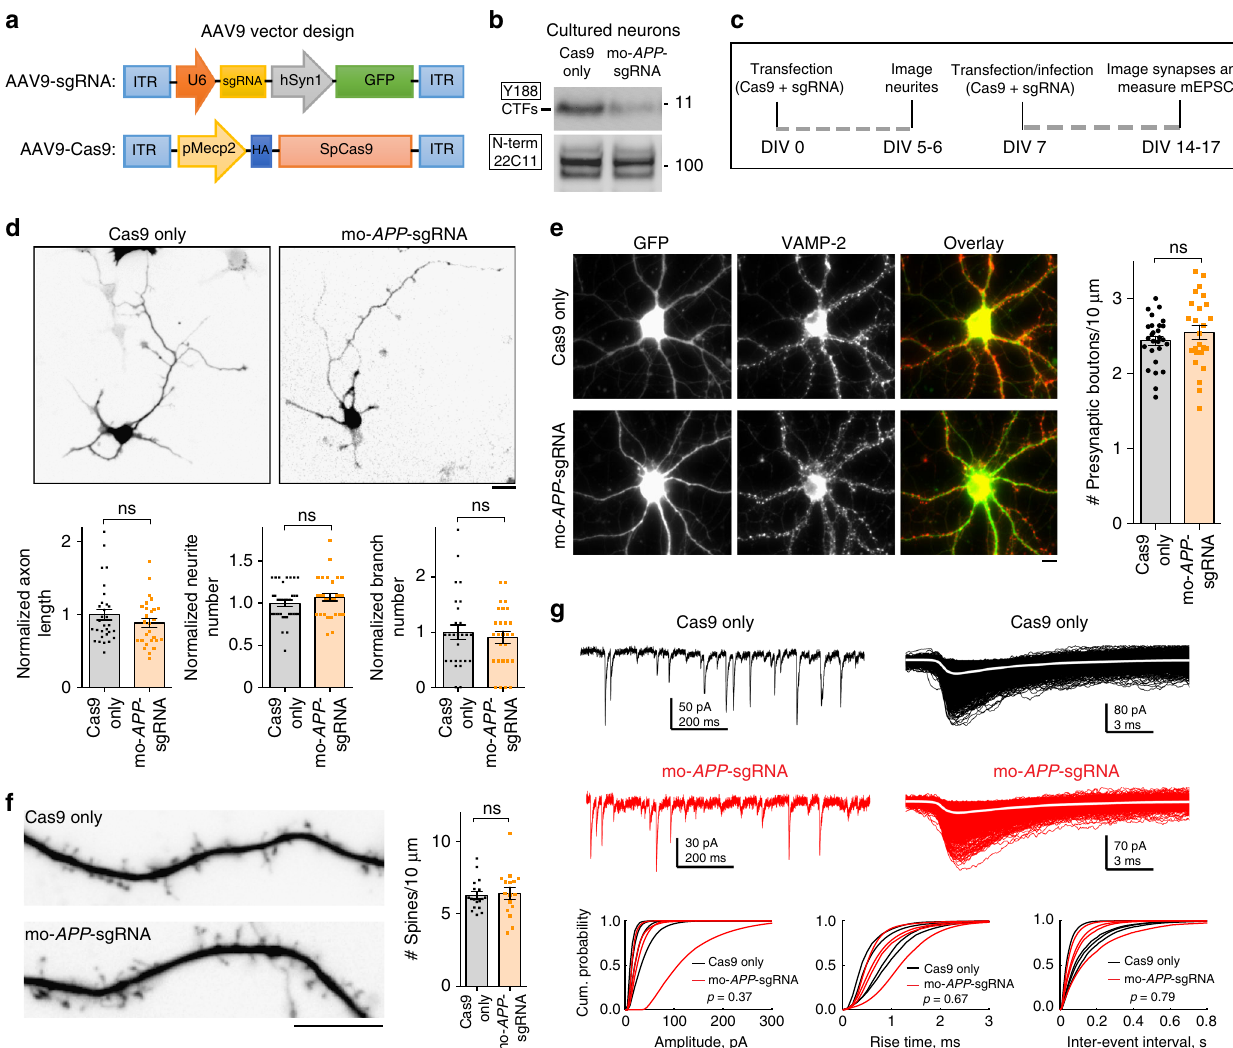
Fig. 3 Effect of APP C-terminus editing on neuronal physiology. a AAV9-sgRNA and AAV9-Cas9 expression vectors. Note that the sgRNA vector co- expresses GFP and the Cas9 is tagged to HA, for identi fi cation of transduced neurons. b Cultured hippocampal neurons were transduced with AAV9s carrying mo- APP -sgRNA/Cas9 (or Cas9 only) and immunoblotted with the Y188 and 22C11 antibodies (with GSI). Note attenuation of CTFs by the mo- APP -sgRNA. c Neurons were transfected (at the time of plating) with APP CRISPR. Neuritic/axon outgrowth was analyzed after 5-6 days. Neurons were transfected or infected at DIV7 with APP CRISPR, and synapse structure/function was analyzed after 14 – 17 days. d Top: Representative images of neurons transfected with the mo- APP -sgRNA/Cas9 (or Cas9 only). Bottom: Quanti fi cations of axon length and number of neurites/branches; note that there was no signi fi cant difference (mean ± SEM; axon length: 30 cells for control and 27 cells for mo- APP -sgRNA from two independent experiments, p = 0.2462; neurite number: 35 cells for control and 31 cells for mo- APP -sgRNA from two independent experiments, p = 0.2289; branch number: 27 cells for both conditions from two independent experiments, p = 0.6008 by two-tailed t -test ; ns = non-signi fi cant). Scale bar 20 μ m. e Neurons were infected with mo- APP -sgRNA/Cas9 (or Cas9 only), and fi xed/stained with the presynaptic marker VAMP2. Note that the presynaptic density (VAMP2 puncta) was similar in both groups (mean± SEM of VAMP2 staining along 27 dendrites for control and 25 dendrites for mo- APP -sgRNA from two independent experiments, p = 0.3132 by two-tailed t -test). Scale bar 10 μ m. f Neurons were transfected with mo- APP -sgRNA/Cas9 (or Cas9 only as controls). Spine density in both groups was similar (mean ± SEM of 18 dendrites for control and 16 dendrites for mo- APP -sgRNA from two independent experiments, p = 0.7456 by two- Top: Representative mEPSC traces in control and mo- APP -sgRNA transduced neurons. Corresponding alignments of mEPSCs with average (white traces) are shown on right. Bottom: Cumulative histograms of mEPSC amplitude, 20 – 80% rise-time and inter-event interval in mo- APP -sgRNA/Cas9 and the Cas9-only infected neurons (note no signi fi cant differences). Source data are provided as a Source Data fi